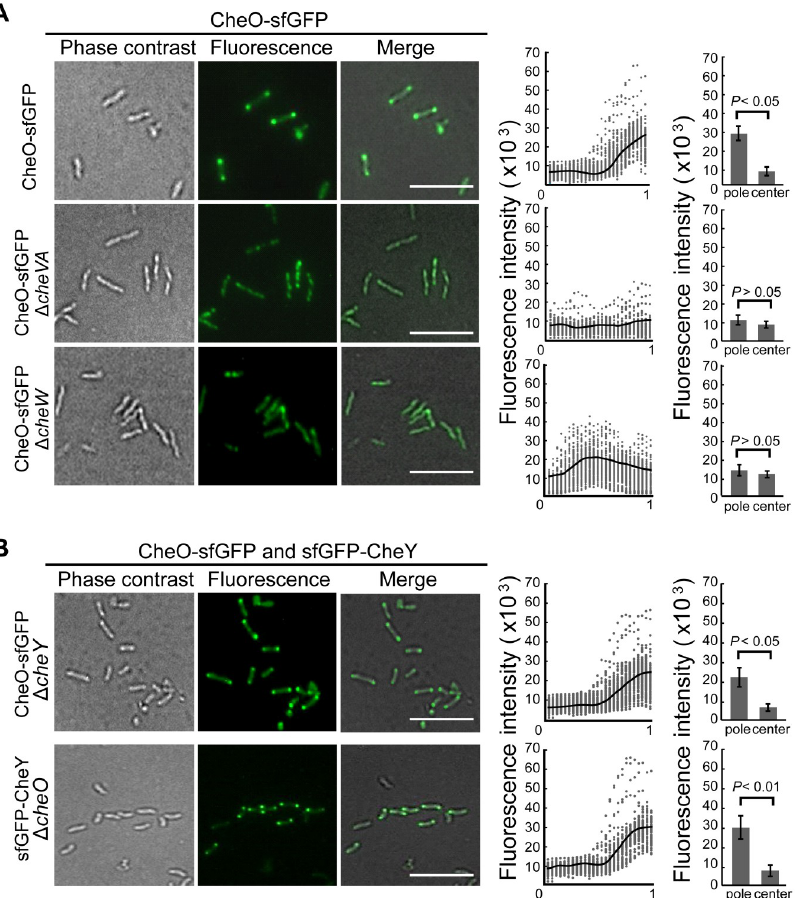
Fig 2. The localization of CheO in C . jejuni . (A) Fluorescence microscopy of the intracellular localization of CheO- sfGFP in C . jejuni wild-type, Δ cheVA and Δ cheW mutant strains. The scatter plot diagram shows the fluorescence intensity of CheO-sfGFP distributed along with the axe of 100 individual cells from the center (0) to the pole (1.0). The black line represents the average intensity of each measuring point. The histogram shows the quantification of the CheO-sfGFP signal intensity at the pole (1.0) and the center (0) of each cell. Data presented as mean ± SEM. Scale bar, 5 μ m. (B) The localization of sfGFP-CheY in Δ cheO mutant and CheO-sfGFP in Δ cheY mutant.